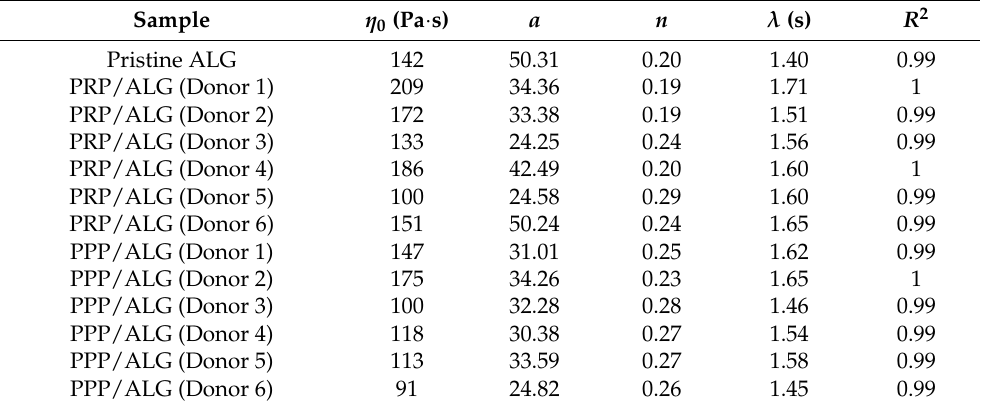
Figure 1. Ultrastructural and rheological properties of pristine ALG, PPP/ALG and PRP/ALG inks. ( a ) Separate ultra- structural scans of the alginate, PRP and PPP hydrogels used to formulate PPP/ALG and PRP/ALG bioinks. Original magnification, 3.00 × k. Scale bar, 10 µ m. ( b ) Storage and loss moduli measured by frequency sweep tests of pristine ALG, PRP/ALG, and PPP/ALG samples for six donors. ( c ) Flow curves of PRP/ALG and PPP/ALG samples and the theoretical Carreau–Yasuda model for six donors. ALG, alginate; PPP, platelet-poor plasma; PRP, platelet-rich plasma. Table 2. Carreau–Yasuda model parameters and shear-rate values for plasma samples of six different